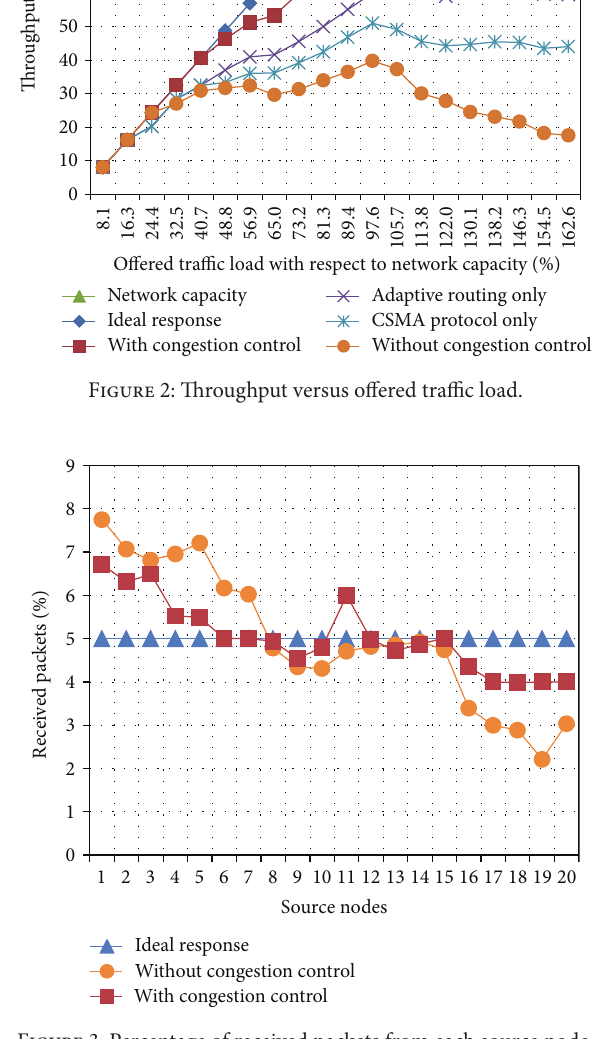
Figure 3: Percentage of received packets from each source